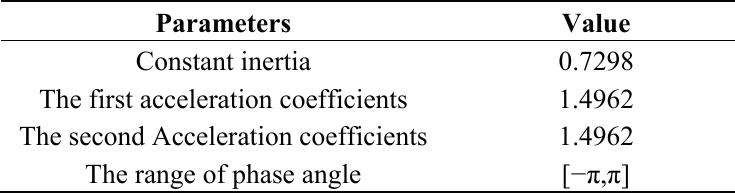
Table 3. The parameters setting of quantum particle swarm optimization (QPSO).